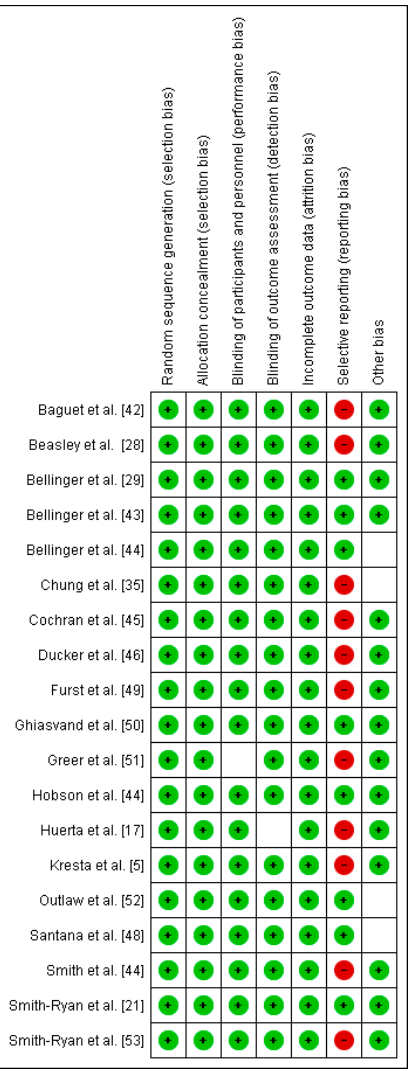
Figure 2. Risk of bias graph: review authors’ judgements about each risk of bias item presented as percentages across all included studies.